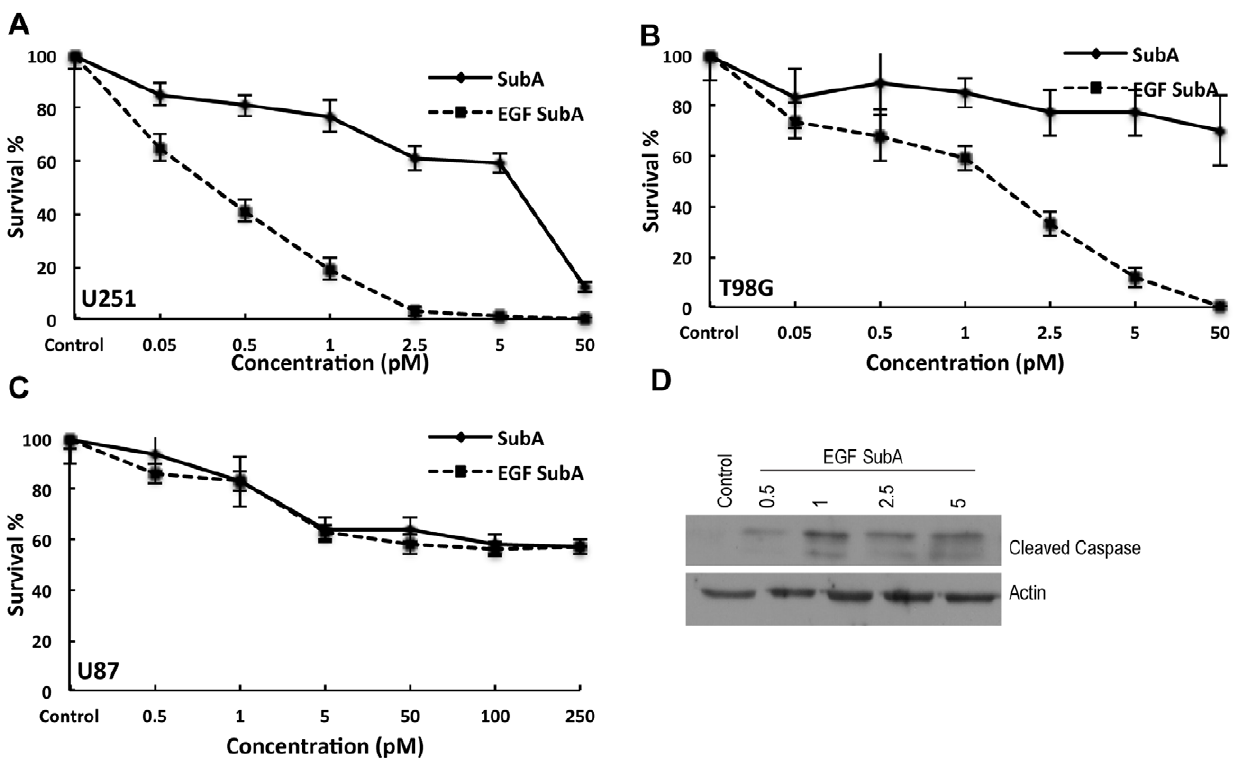
Figure 3. The influence of SubA and EGF-SubA on glioma cell survival. A clonogenic assay was performed to study the cytoxicity of SubA and EGF-SubA in U251 (A), T98G (B) and U87 cells (C). Cells were seeded as single cell suspensions in six well culture plates, allowed to adhere, and treated with the stated concentrations of SubA or EGF-SubA for 24 h. Plates were then replaced with fresh culture media and surviving fractions were calculated 10 to 14 d following treatment. Cell survival was significantly different between SubA and EGF SubA treatment in U251 (p , 0.0001) and T98G (p , 0.0001 at concentrations $ 0.5 pM) and not significant in U87 cells (p=0.2112). (D) Immunoblotting of total cellular protein from U251 cells treated with EGF-SubA at the stated concentrations for 24 h demonstrates EGF-SubA induced apoptosis, as determined by cleaved caspase 3. Each figure is a representative of three independent experiments. doi:10.1371/journal.pone.0052265.g003 alone (n =6) subcutaneously behind the neck. A total of three doses were delivered every other day. The tumor volume (L x W x